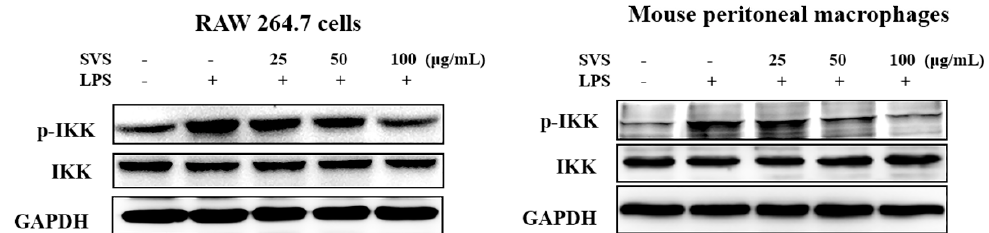
Figure 6. The effects of stevioside on the LPS-induced activation of IKK in RAW 264.7 macrophages and mouse peritoneal macrophages. RAW 264.7 cells were pretreated with or without the indicated concentrations of stevioside for 1 h and then stimulated with LPS (1 μ g/mL) for 15 min. Whole cell lysates were isolated and subjected to immunoblots. GAPDH was used as an internal control. SVS, stevioside.